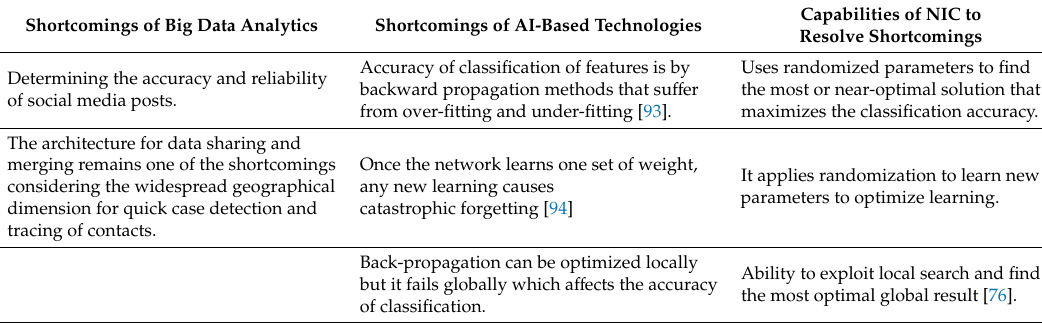
Table 4. Shortcomings of AI-based technologies and capabilities of nature-inspired computing (NIC). Shortcomings of Big Data